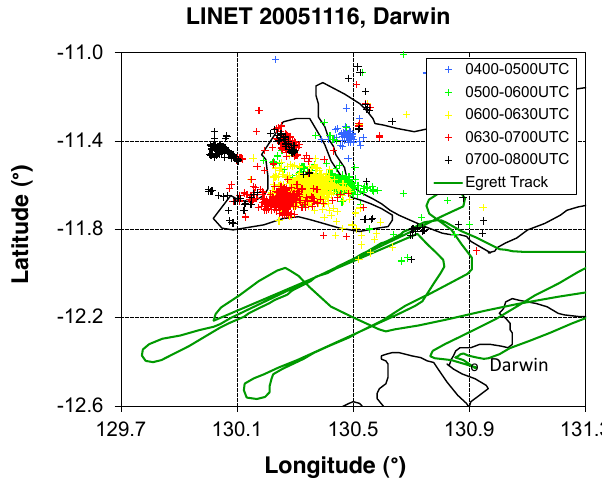
Fig. 6. Lightning strokes (CG and IC) observed by LINET on 16 November 2005 for the Hector thunderstorm that tracked across the Tiwi Islands between roughly 14:30–18:30LT (05:00–09:00UTC). The solid green line represents an approximation of the Egrett flight track through the anvil between 06:28–09:47UTC (Isaac and Hacker, 2007).